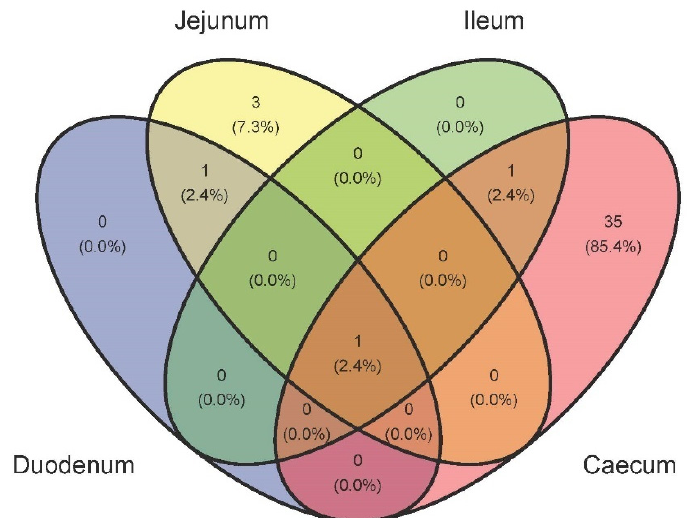
Figure 7. Venn diagram of shared genera between intestine segments independently of age.